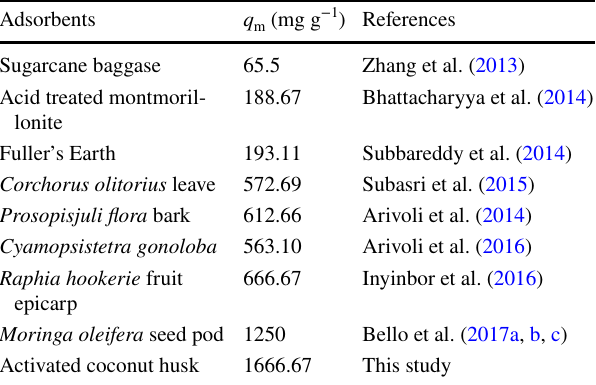
Fig. 9 Plot of pseudo-second-order kinetic model at 323 K for Rh-B dye adsorption onto CHA